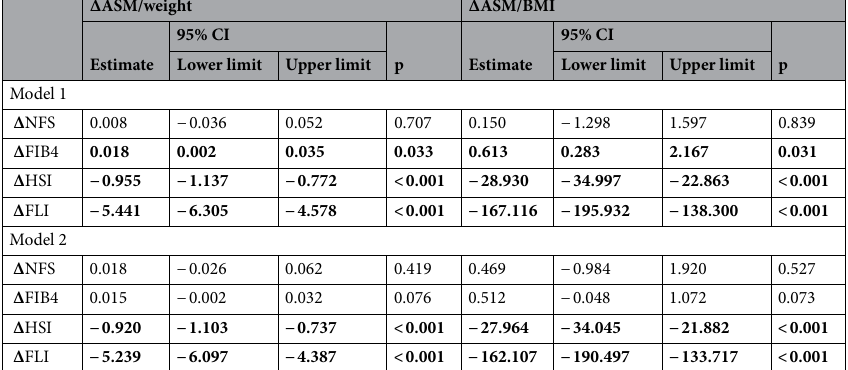
Table 5. Regression analysis of muscle mass variances as predictors for changes in NAFLD-related indices over 6 years (bold: p value < 0.05). CI Confidential interval, ASM Appendicular skeletal muscle mass, BMI hypertension, and metabolic